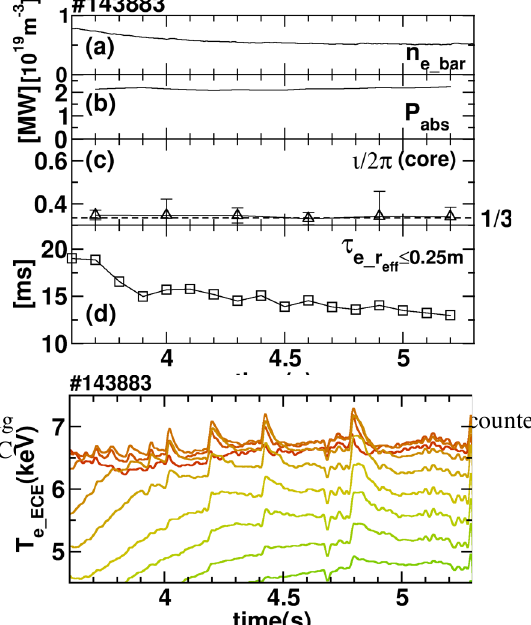
Fig.16 : Low pass filtered (f cutoff =40Hz) ECE measured at 0.02 m ≤ r eff ≤ 0.23 m in the same discharge of Fig.15.